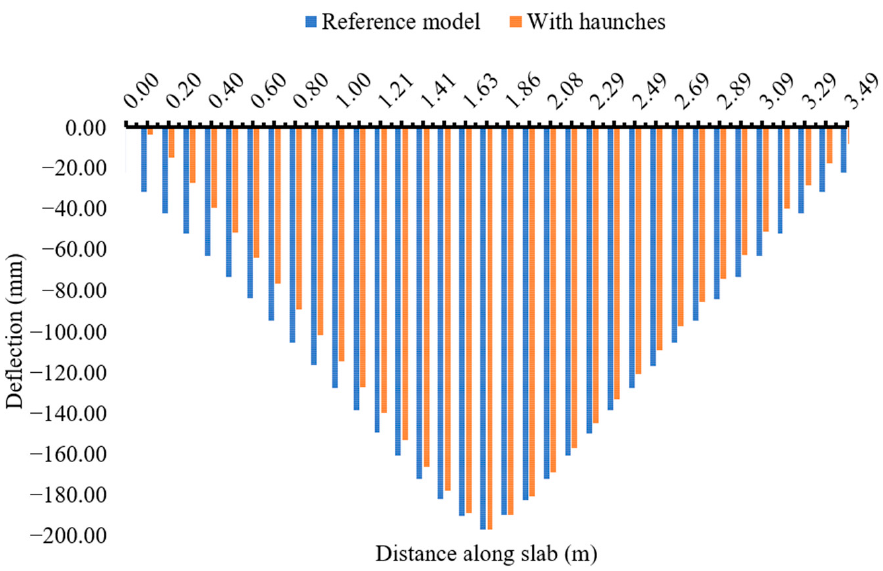
Figure 13. Comparison of deflections in the slabs of reference and haunched culverts.